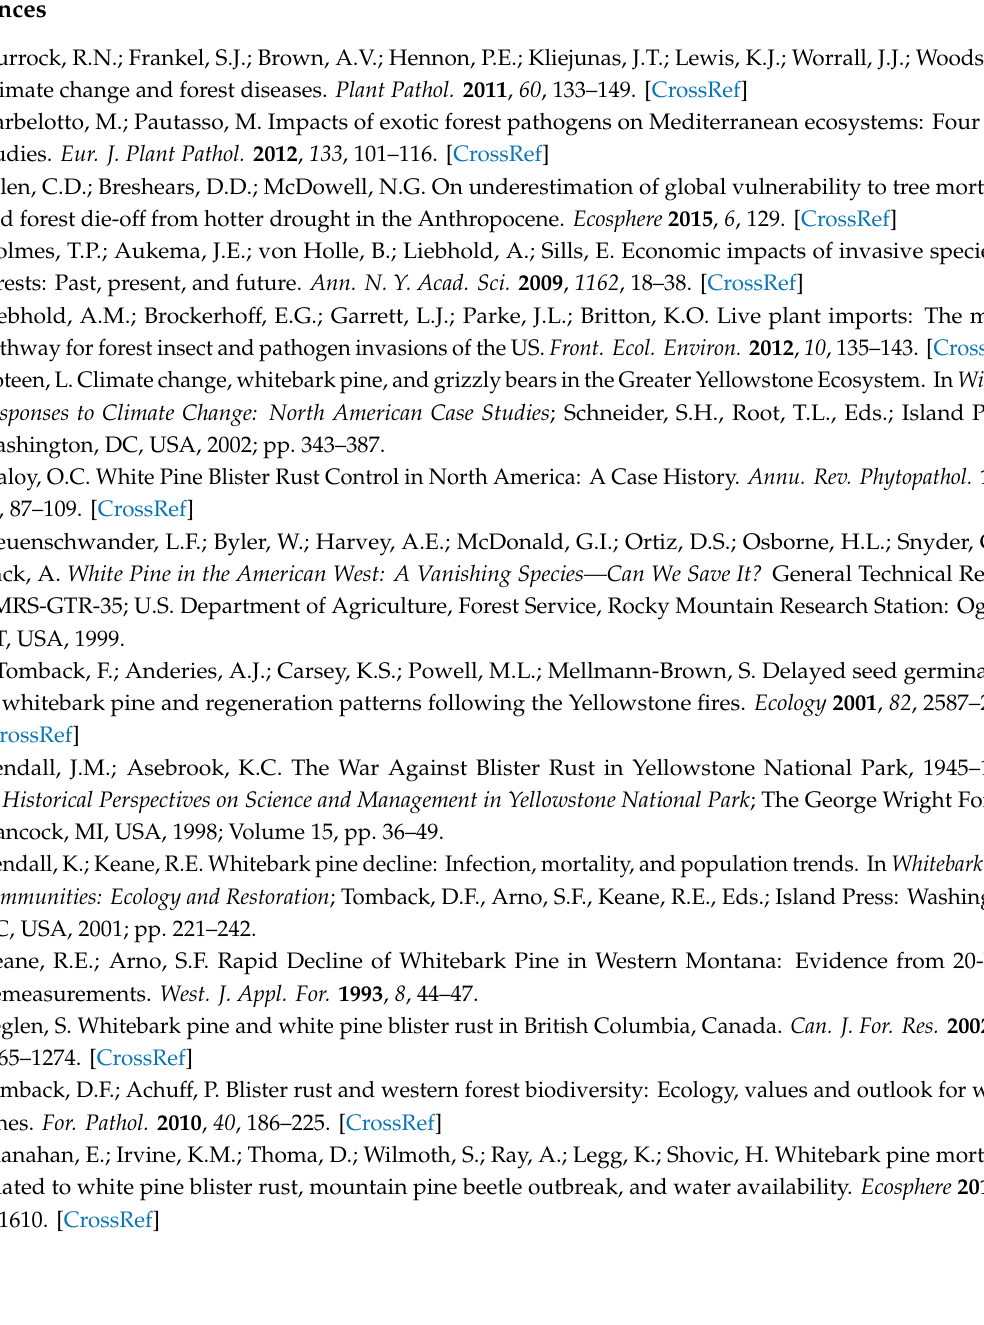
Table S1: Correlation matrix for selecting climate variables considered for analysis with blister rust